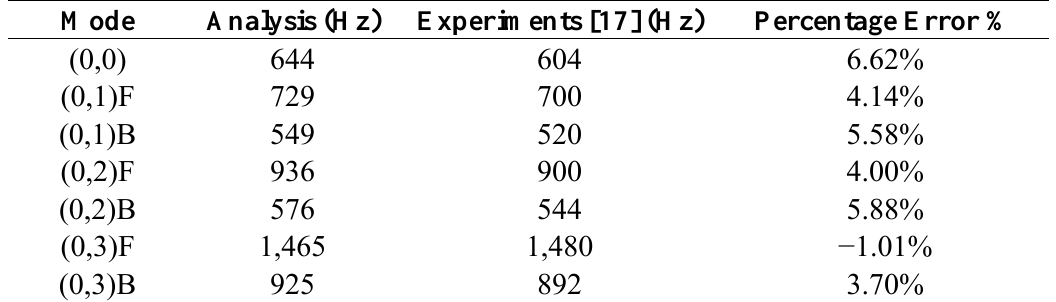
Table 2. Comparisons of Numerical and Experimental Results (Rotating Speed Ω = 5,400 rpm).